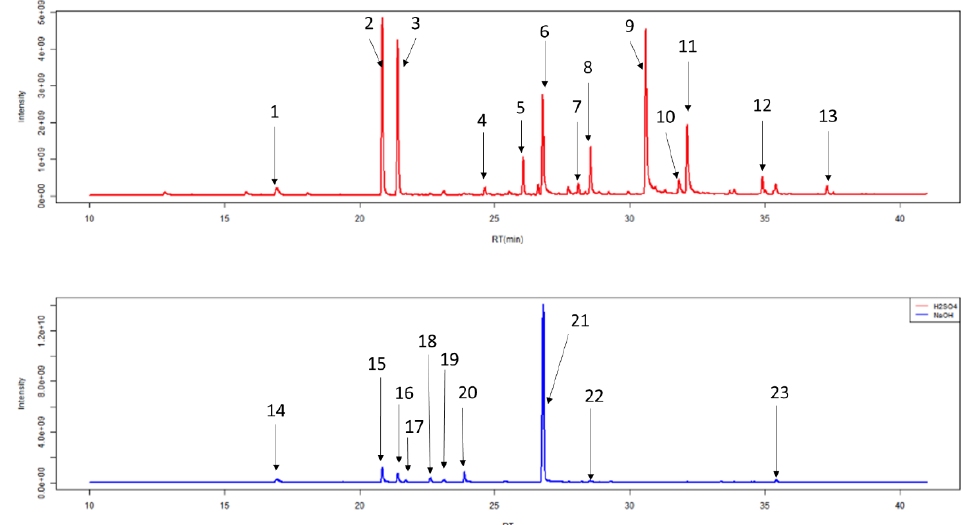
Figure 7. Example of typical chromatograms of duplicate 1 mL urine samples generated from HS-SPME-GC-MS following treatment with 0.2 mL of 5 M H 2 SO 4 (red) or 5 M NaOH (blue). The 13 most